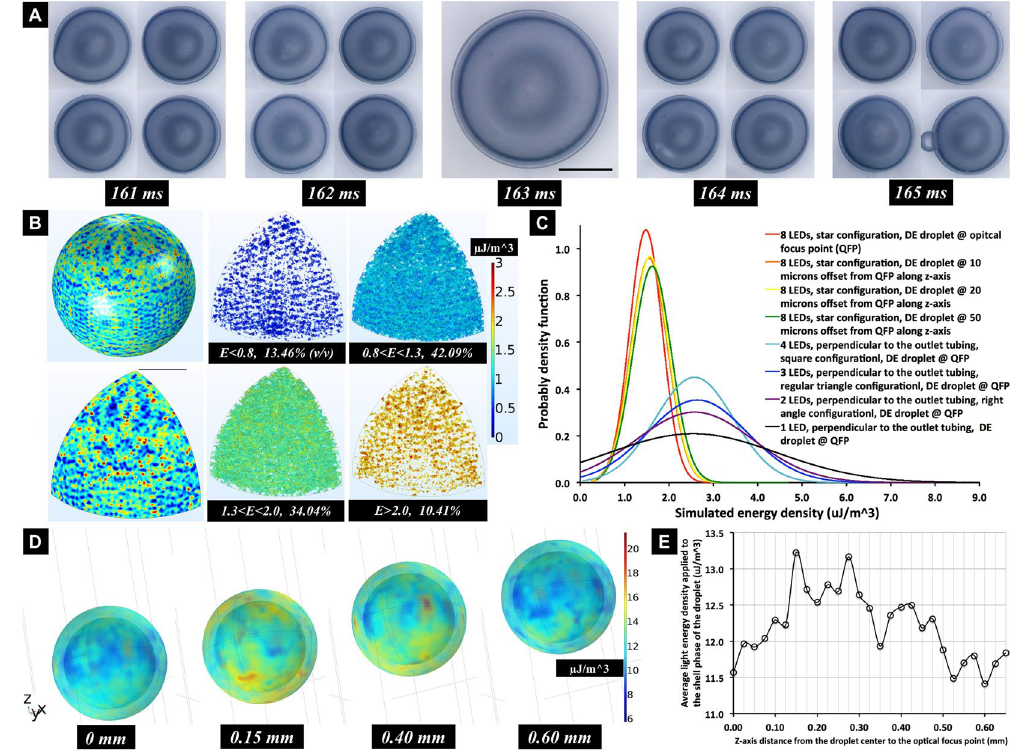
Figure 3. On-flow shell fabrication. ( A ) Images of the TMPTA capsule-shells, that were UV cured, under different delay times, d , between the initial droplet detection and the UV actuation. Scale bar denote 500 microns. ( B ) Simulation results of the UV light energy distribution within the shell phase of the φ 1 mm concentric and spherical double emulsion droplet, while it is placed at the reactor optical focal point. The right four images show the spatial distribution of different light energy densities ( E ) inside the shell phase, with their volume ratios relative to the whole droplet. (C ) Probably density functions (n = 12,649 for each curve) of the simulated UV light energy densities, within the entire TMPTA shell, for different DE droplet locations, along the z-axis, on the centerline of the outlet tubing, as well as different LEDs configurations, indicate the uniformity of the UV irradiation upon the DE droplet. (D ) Simulated UV light energy distribution upon the DE droplet, when it is rising in z-axis (flow direction) for 0.6 mm, during the 70 ms LEDs actuation period. (E ) Graph of simulated average light energy density in the shell layer, when it is rising in z-axis, during the LEDs actuation